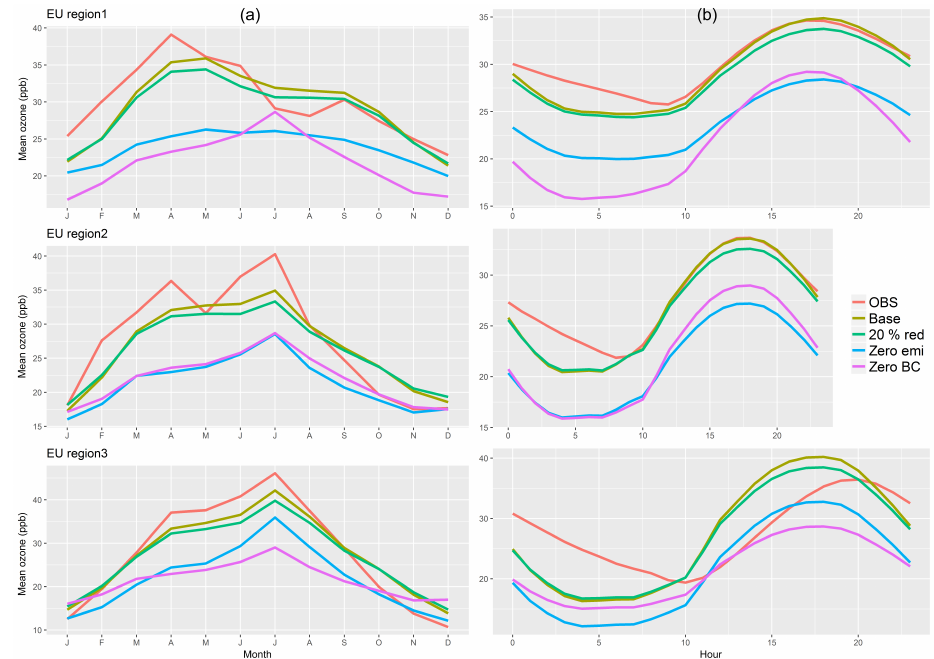
Figure 3. Average monthly (column a ) and diurnal curves (column b ) constructed from the January–December 2010 time series of hourly ozone observations and model simulations for three European